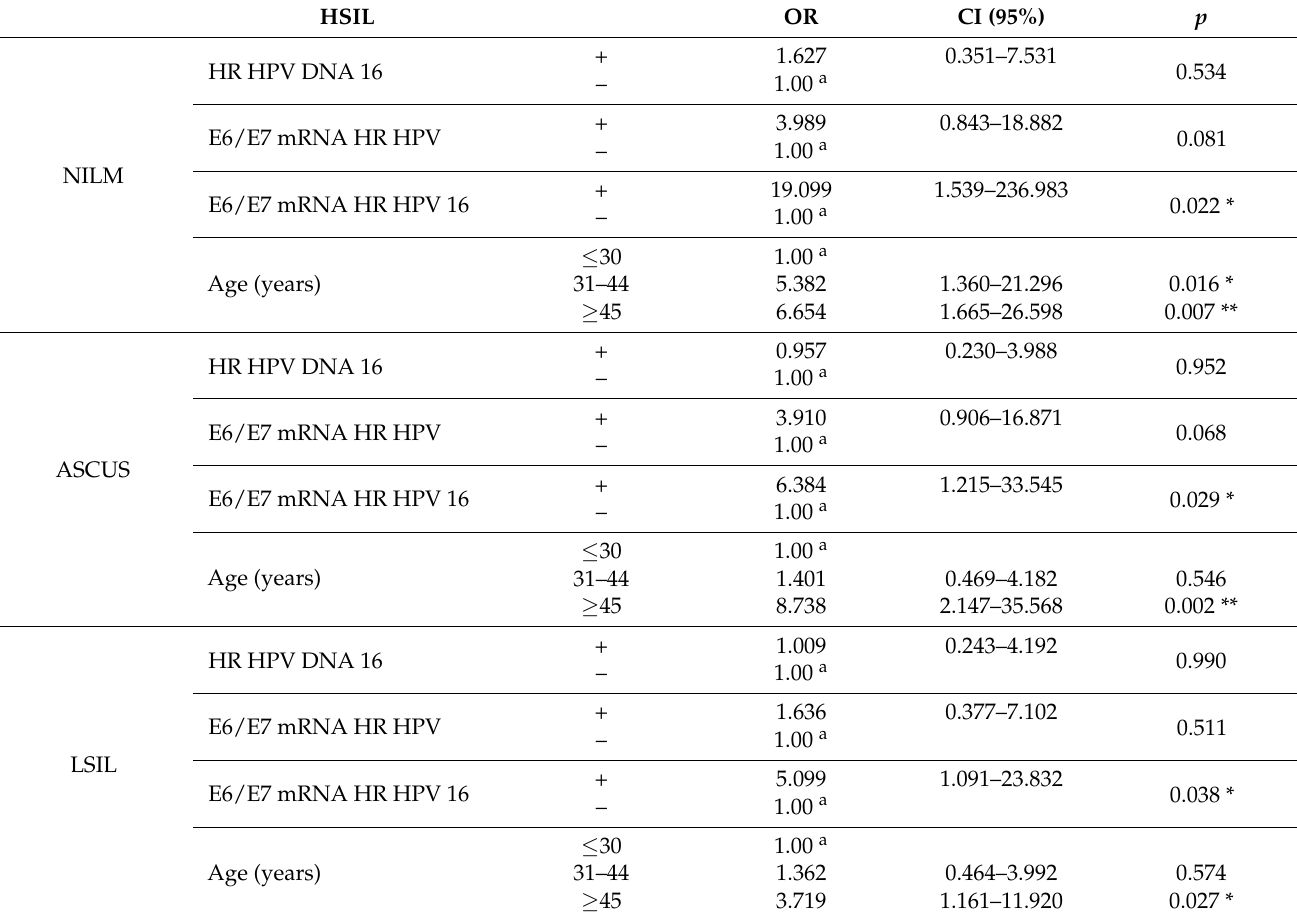
Table 12. Analysis of the mutual influence of relevant factors for HSIL development. HSIL OR CI (95%)